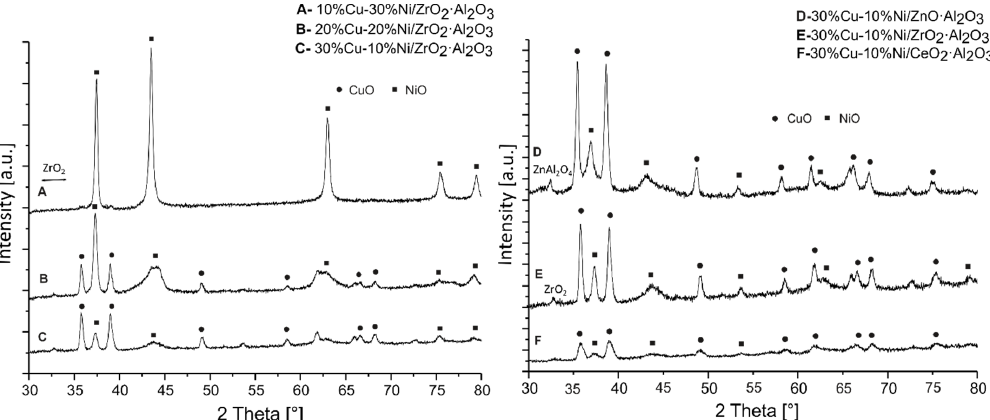
Figure 7. X-ray diffraction curves of various bimetallic catalysts calcined at 400 °C for 4 h in an air Figure 7. X-ray di ff raction curves of various bimetallic catalysts calcined at 400 ◦ C for 4 h in an atmosphere. air